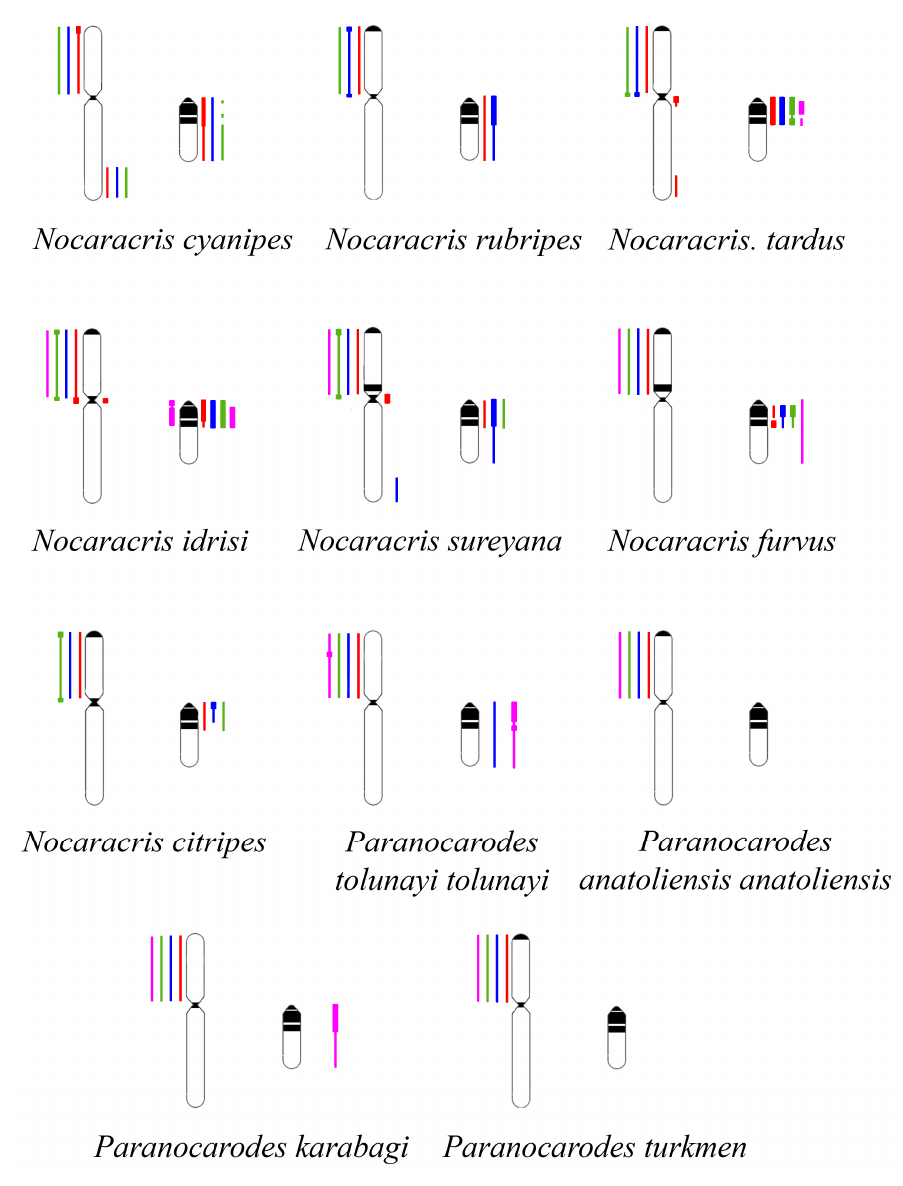
Figure 8. Schematic representation of the neo-sex chromosome painting in Nocarodeini species. The regions painted with the XL DNA probes showed on the left from the chromosome. The regions painted with the neo-Y DNA probes showed on the right from the chromosomes: NcyXl and NcyY DNA probes (red); NruXl and NruY DNA probes (blue); NtaXl and NtaY DNA probes (green); PtoXl and PtoY DNA probes (cyan). The thick line shows intensive painting, while thin line shows less intensive painting.